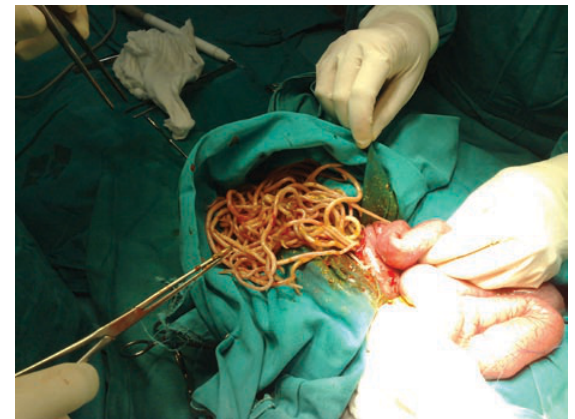
Figure 3. Manual removal of live Ascaris lumbricoides worms from the longitudinal incision of the ileum.